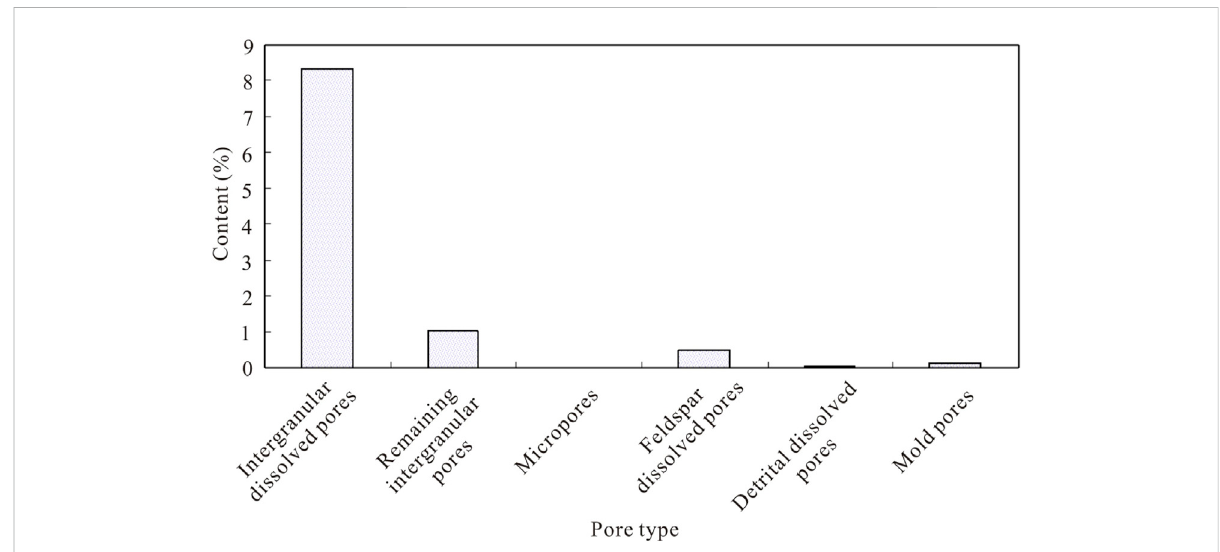
FIGURE 8 Pore types and proportions in the Chang 1 Member sandstone in the study